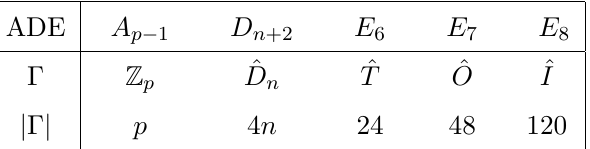
Table 1 . ADE classi(cid:12)cation of the (cid:12)nite subgroups of